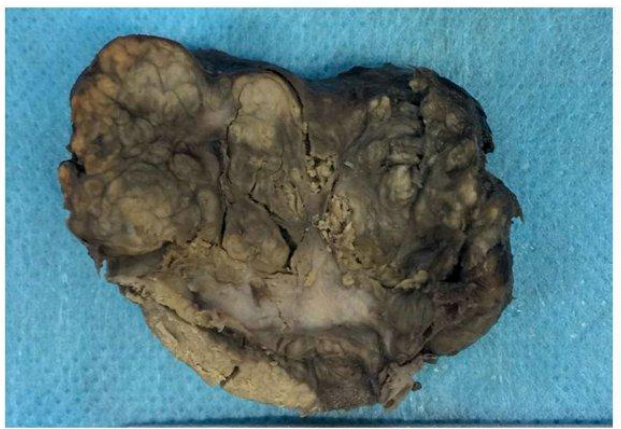
Figure 2: A 6x4x3 cm, nodule of focal nodular hyperplasia found incidentally in a young man. It shows the gross appearance of classical FNH. Nodular appearance lesion is observed, in addition the typical central scar with radial fibrous